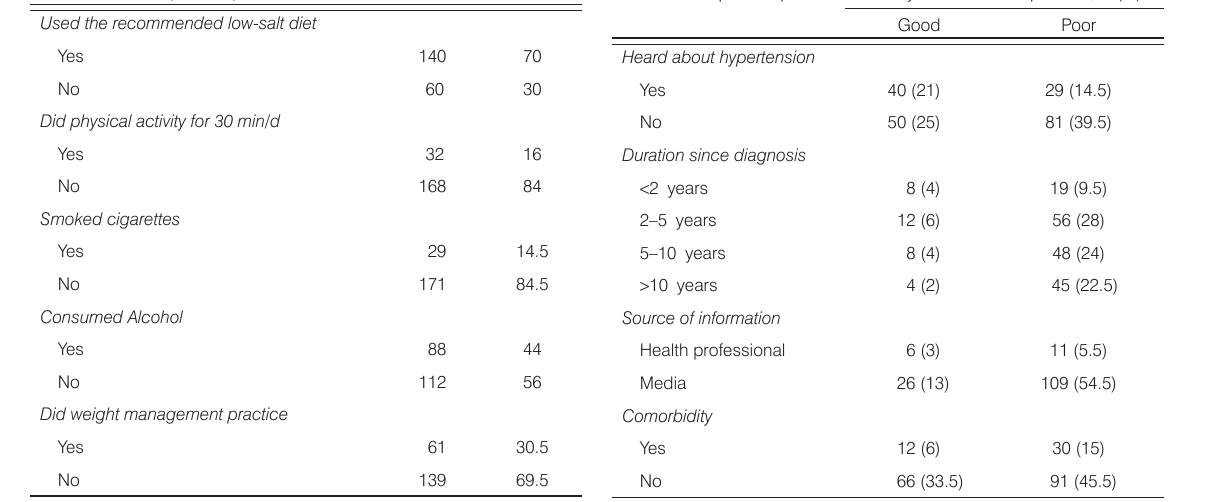
Table 3. Knowledge about lifestyle modification practice among hypertensive patients.